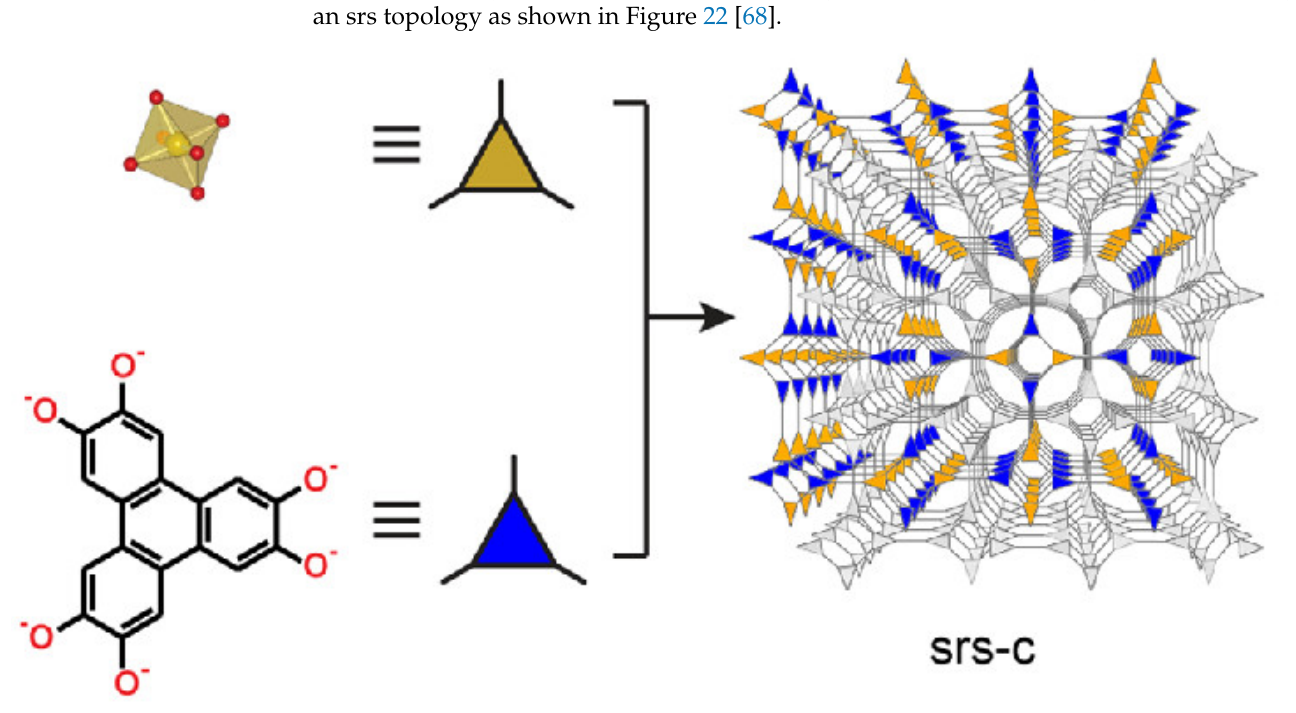
Figure 22. Structure of SiCOF-5 net. Reprinted (adapted) with permission from [68]. Copyright 2018 American Chemical Society.